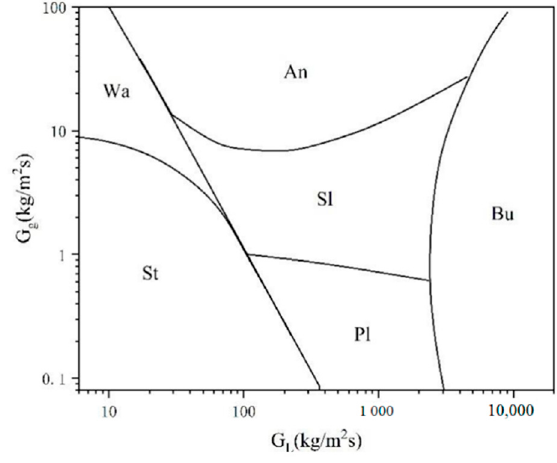
Figure 14. Flow pattern diagram of gas–liquid two-phase fluid.